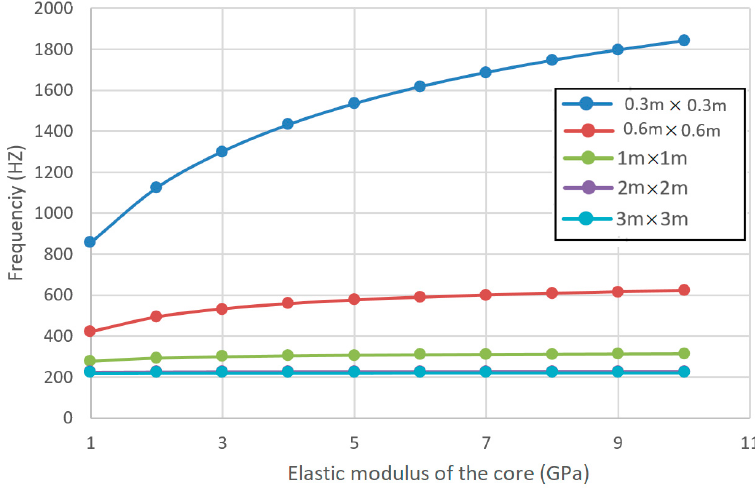
= 1 , h 1 = 0.1, = 1 , (cid:3035) (cid:3117) = 0.1, (cid:3035) (cid:3118) = b h (cid:3035) (cid:3035) (cid:3029)